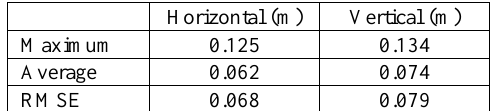
Table 3. Results of accuracy evaluation of the developed vehicle-loading system